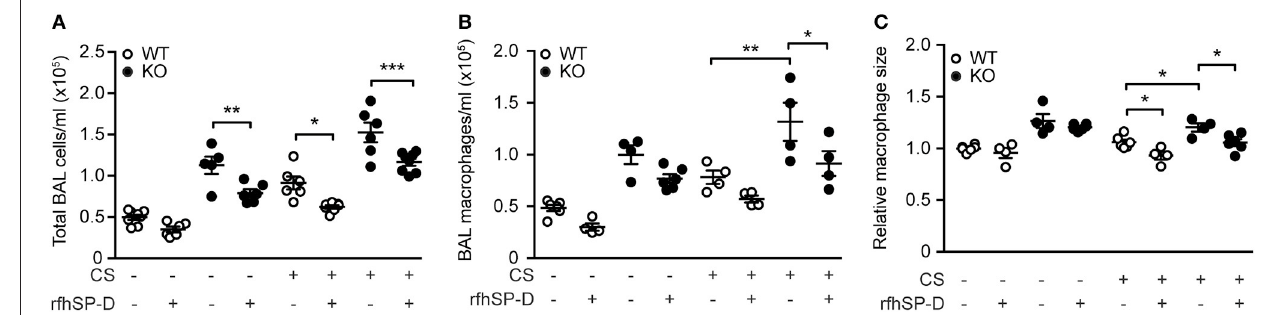
FIGURE 4 | Therapeutic administration of recombinant SP-D fragment attenuates airway inflammation caused by acute cigarette smoke (CS) exposure in mice. Treatment with recombinant fragment of human SP-D (rfhSP-D) lowers (A) total cell number, (B) macrophage number, and (C) macrophage size in bronchoalveolar lavage fluid (BAL) of CS-exposed mice. n = 4–8. * p < 0.05, ** p < 0.01, *** p < 0.001, analyzed by one-way ANOVA followed by Bonferroni’s test.